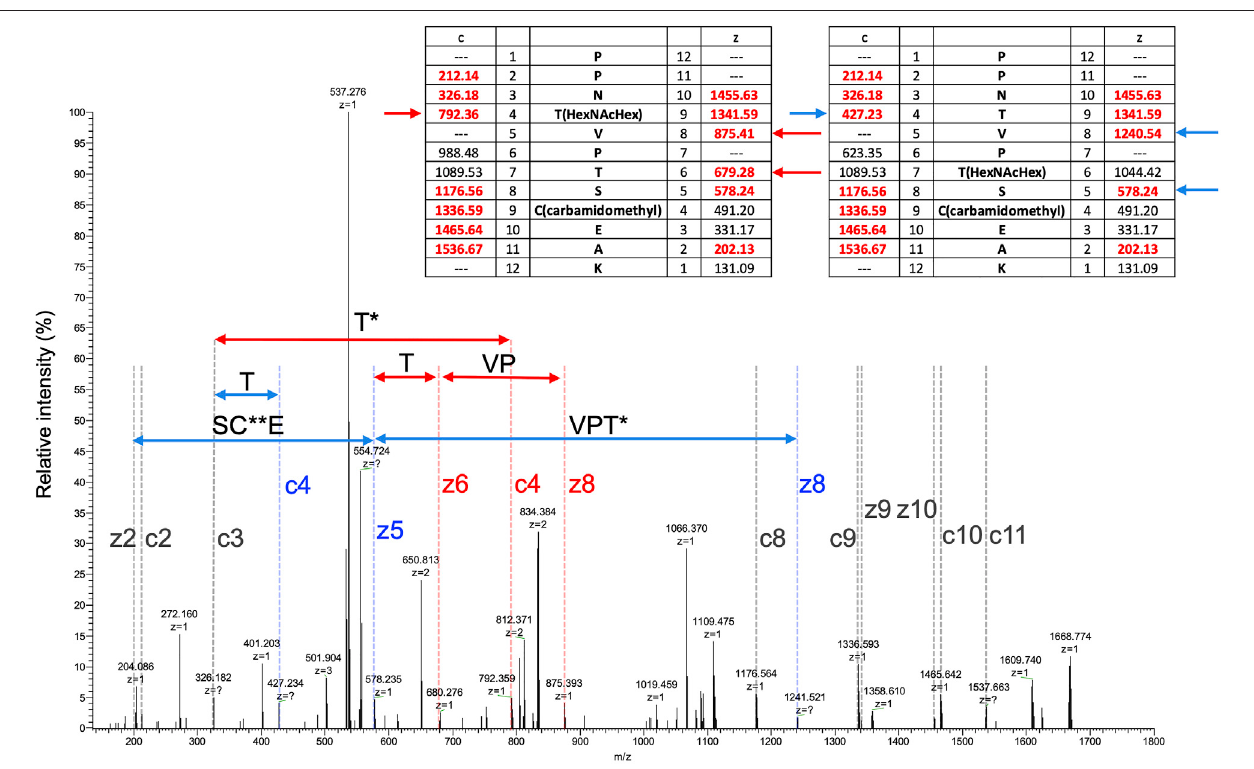
FIGURE 2 | EThcD MS/MS spectrum of a peptide (PPNTVPTSCEAK) having Hex(1) HexNAc(1). MS/MS acquired at the time of (3) in Supplementary Figure S3 . Masses of predicted fragment ions are listed in the inset tables. Fragment ion characteristics of glycosylation at Thr-30 are indicated in red, those at Thr-33 are in blue, and common ones are in gray. HexNAcHex and carbamidomethyl modi fi cations are indicated by single and double asterisks,